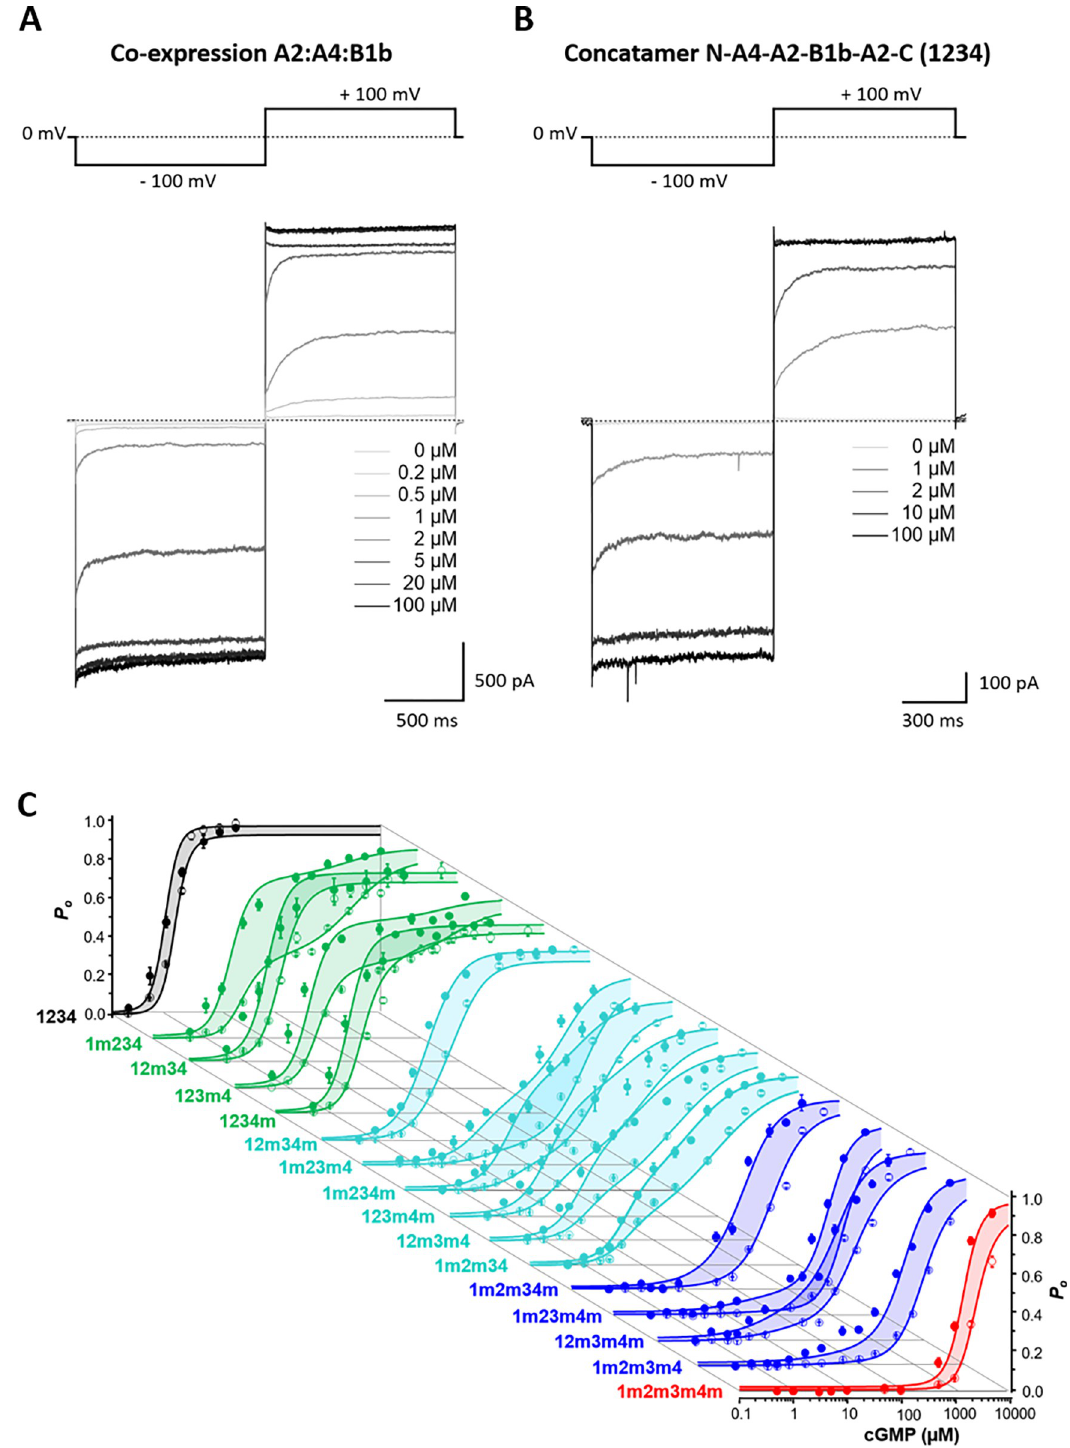
Fig 2. Concentration-activation relationships (CARs) and cooperative affinity increase at each subunit. Current amplitudes were measured as late currents at the end of the pulses at +100 mV and -100 mV. Stepping the voltage from negative to positive voltages generates an activating component in the time course. ( A ) Currents of heteromeric channels generated by co-expression of wt subunits with a cRNA ratio A2:A4:B1b of 2:1:1. ( B ) Currents generated by the concatamer N-A4-A2(1)-B1b-A2(2)-C show a similar activating component of the time course as co-expressed channels. ( C ) Global fit of 32 CARs with the 29 HACO model